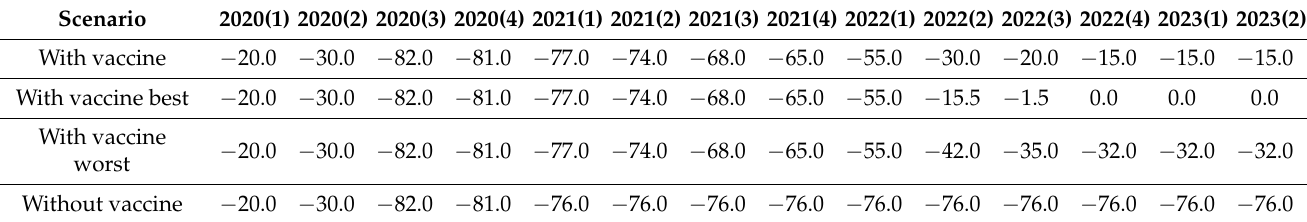
Table A4. Percentage (%) reduction in real education exports with and without vaccine vs. no COVID scenario.